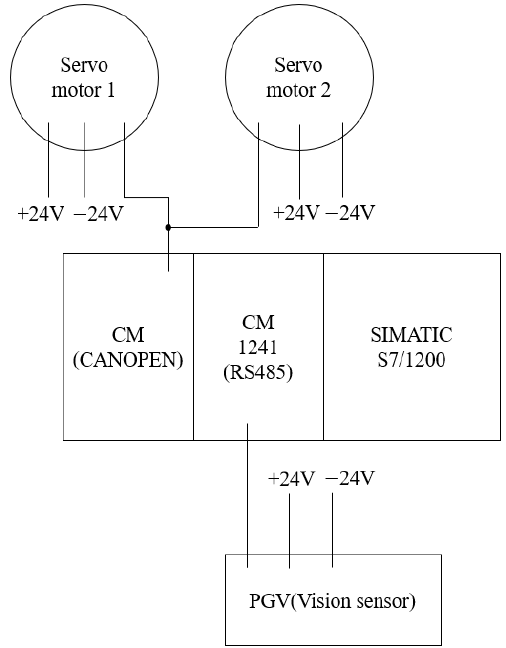
Figure 15. AGV steering control system diagram.